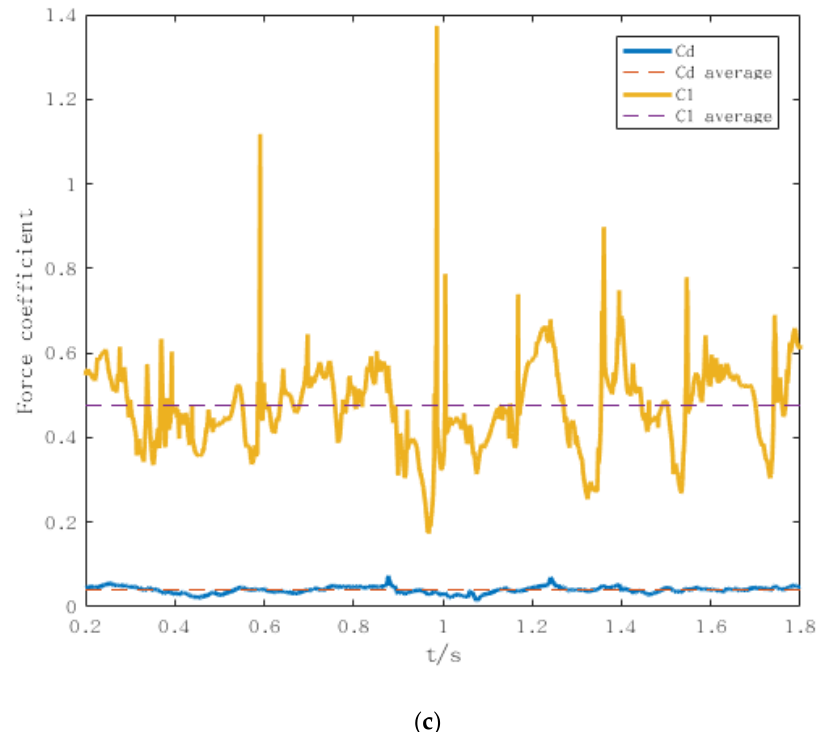
Figure 10. Variation of lift and drag coefficient with time. ( a ) SST k- ω turbulence model. ( b ) Modified SST k- ω turbulence model. ( c ) Smagorinsky’s turbulence model.